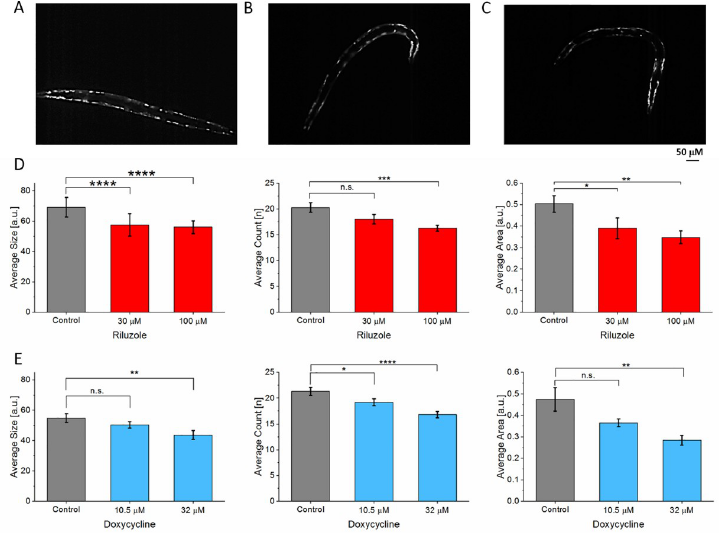
Fig 5. Quantitative analysis of morphology in ALS model (AM725). (A) SOD1 protein aggregates in ALS model before treatment (n = 35). (B) After treatment with 30 μ M (n = 33). (C) After treatment with 100 μ M doxycycline (n = 35). (D) Quantification of protein aggregates after riluzole treatment. 30 μ M riluzole showed significant changes in average size and area while its effect on the thrashing force was not significant. (E) After treatment with doxycycline in terms of aggregate size, count, and average area. In the case of doxycycline, 32 μ M (n = 40) showed significant changes while 10.5 μ M (n = 39) showed no significant changes in terms of average size and area. Significant differences were analyzed using t-test, error bars indicate